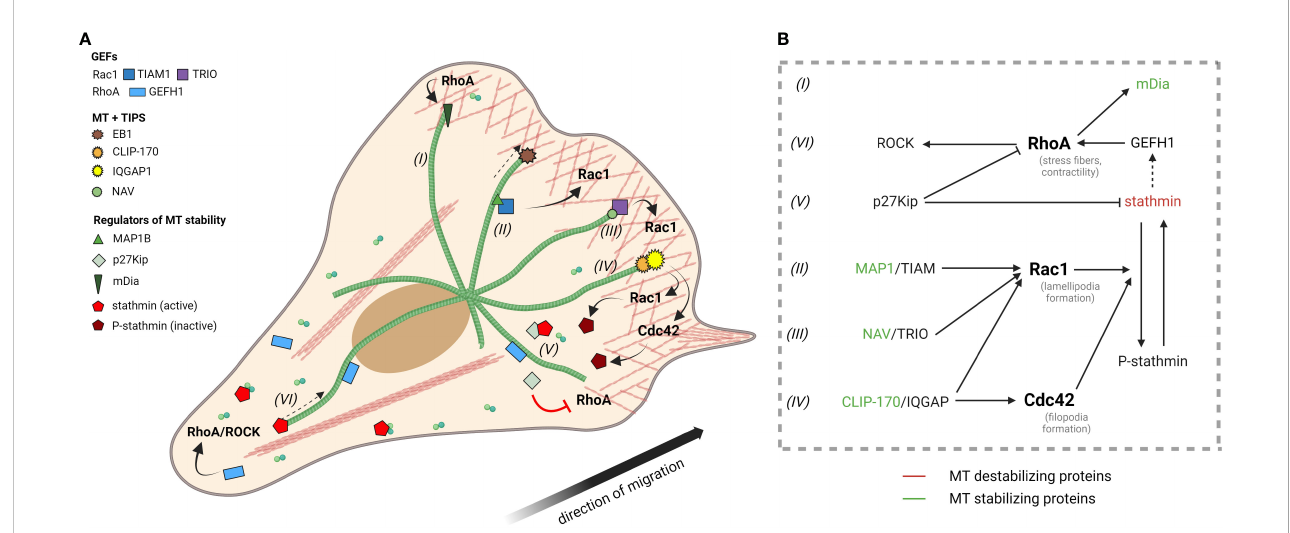
FIGURE 1 Microtubules and RhoGTPase signaling. (A) The length and stability of MTs in migrating cells is interconnected with RhoGTPase signaling and depends on cell polarization. MTs preferentially elongate toward the leading edge, where their growth is enhanced by various MT end-binding proteins and MT stabilizing proteins, which further interact with numerous Rac1 and Cdc42 activators (see TRIO, TIAM and complex IQGAP/CLIP-170). At the leading edge, Rac1 and Cdc42 signaling contributes to actin polymerization (pink network), but also MT stabilization by phosphorylation of stathmin. MT stability at the leading edge is supported by p27 Kip , which binds stathmin, preventing its activation. Similarly, p27 Kip prevents RhoA pathway activation. On the contrary, at the trailing edge, MTs are depolymerized and Rho/ROCK signaling pathway dominates. Stathmin is not phosphorylated by Rac1 or Cdc42 and remains active – able to sequester tubulin dimers and destabilize MTs. MT disruption leads to release, and thus activation, of GEFH1 from MTs into the cytoplasm, where it promotes activation of the RhoA/ROCK pathway. Roman numerals labeling MTs refer to part (B) of the Figure. (B) Schematic illustration showing interaction between MT stabilizing (green)/destabilizing (red) factors and RhoGTPases. Created with